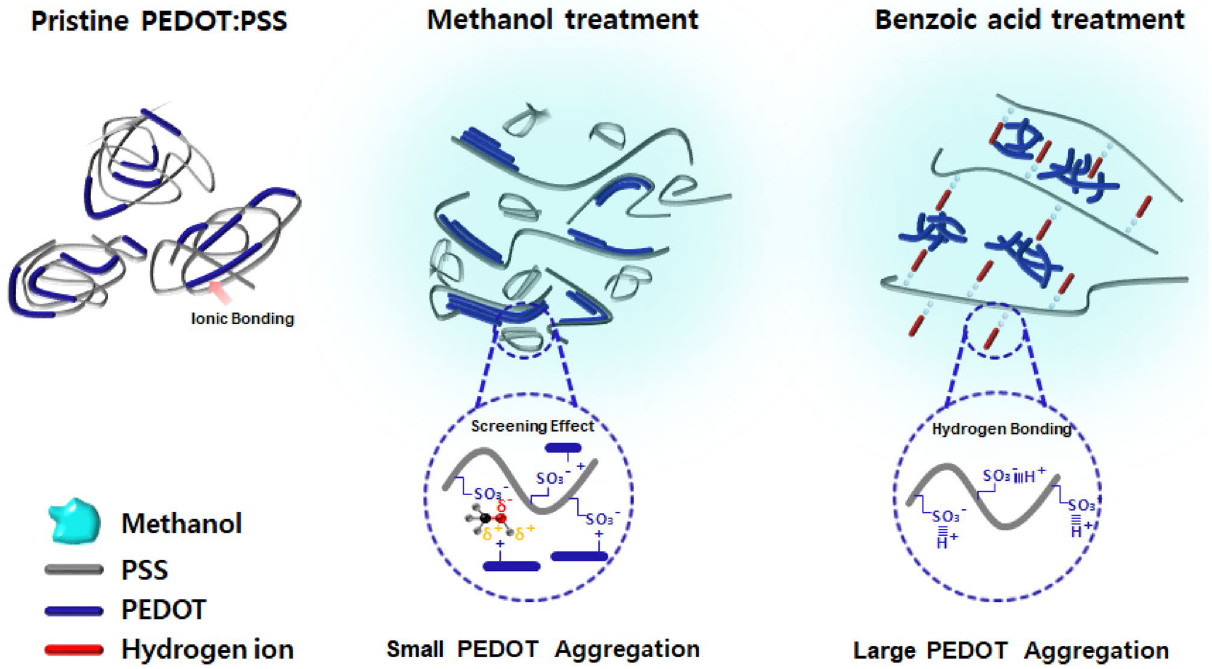
Figure 3. Schematic illustrations of the conductivity enhancement mechanism of PEDOT:PSS film with benzoic acid treatment (Kang et al.).